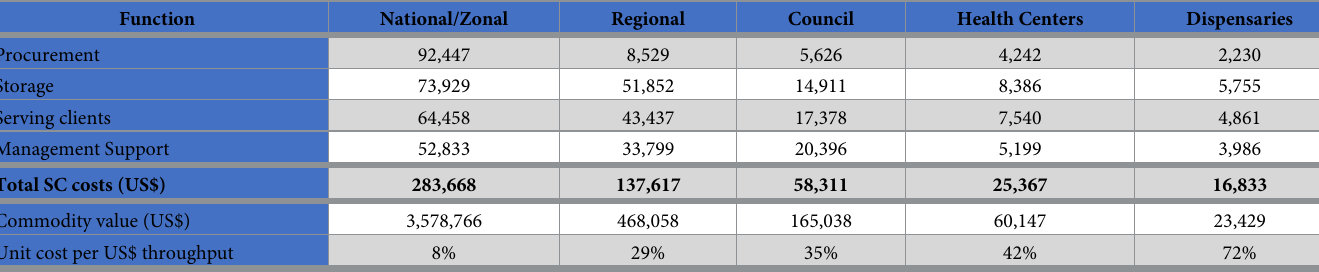
Table 5. Average annual supply chain operation costs, by health care facilities level (2020 US$) (N = 26). Function